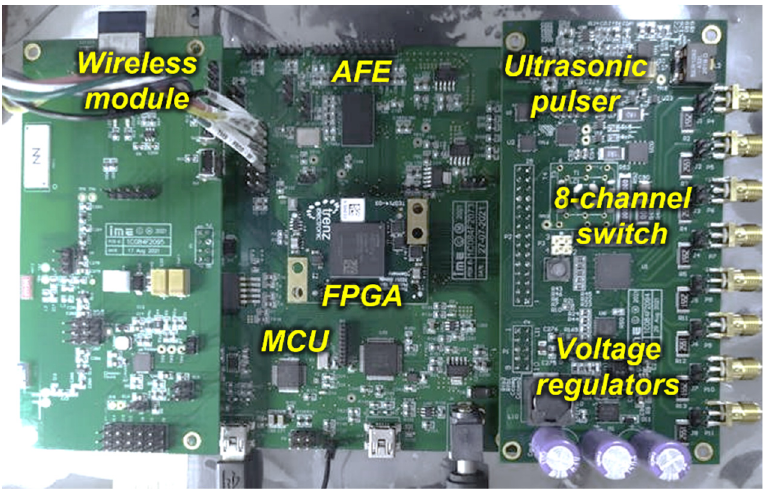
Sensors 2022 , 22 , 5724 Figure 4. ( a ) Block diagram and ( b ) photo of the modules in the active ultrasonic SHM edge circuit.